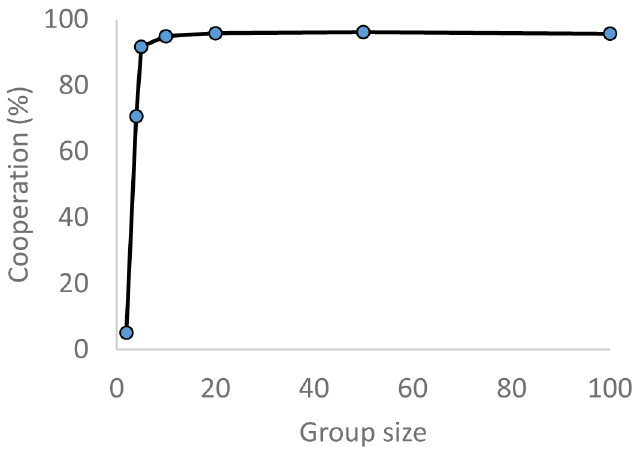
Fig 5. Cooperation and group size. The mean level of cooperation across 10 simulations, each of 10,000 generations is shown in relation to the group size in which individuals interacted using image scoring with partner choice, maintaining m = 1 and island size = 100. Standard errors are too small to be